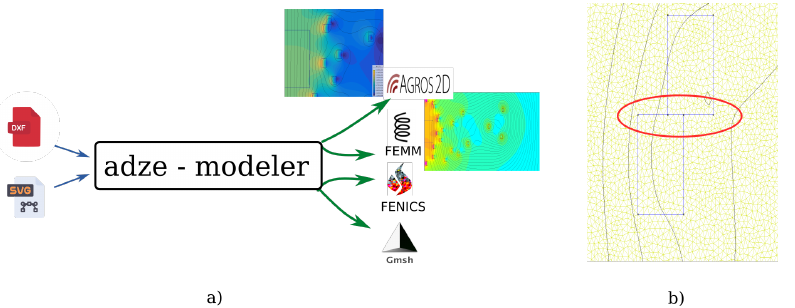
Figure 2. The image ( a ) shows the functionalities used and the workflow that was realized via the Adze-modeler. ( b ) The usage of the collision detection function, which automatically replaces the overlapping edges due to the optimization